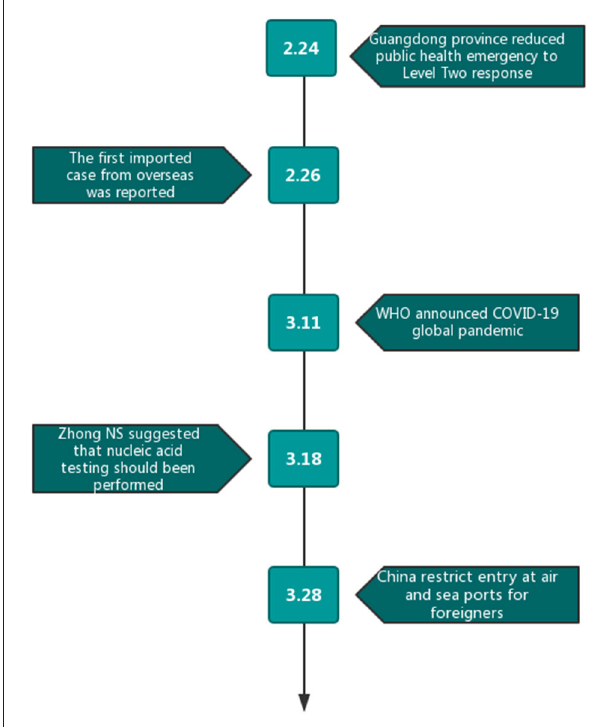
FIGURE 1 | Date of occurrence of important events and implementation of preventive